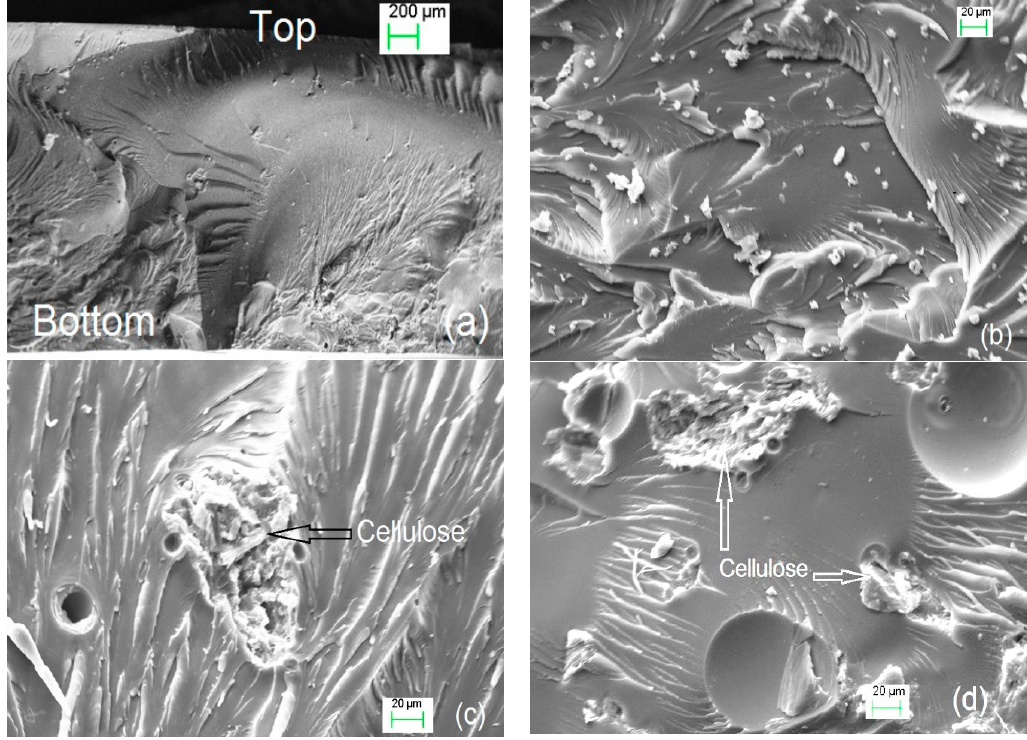
Figure 5. SEM images of the fracture surfaces of ( a ) 1% EMC loading composite with whole thickness; ( b ) neat epoxy; ( c ) 3% EMC loading composite; and ( d ) 5% EMC loading composite.